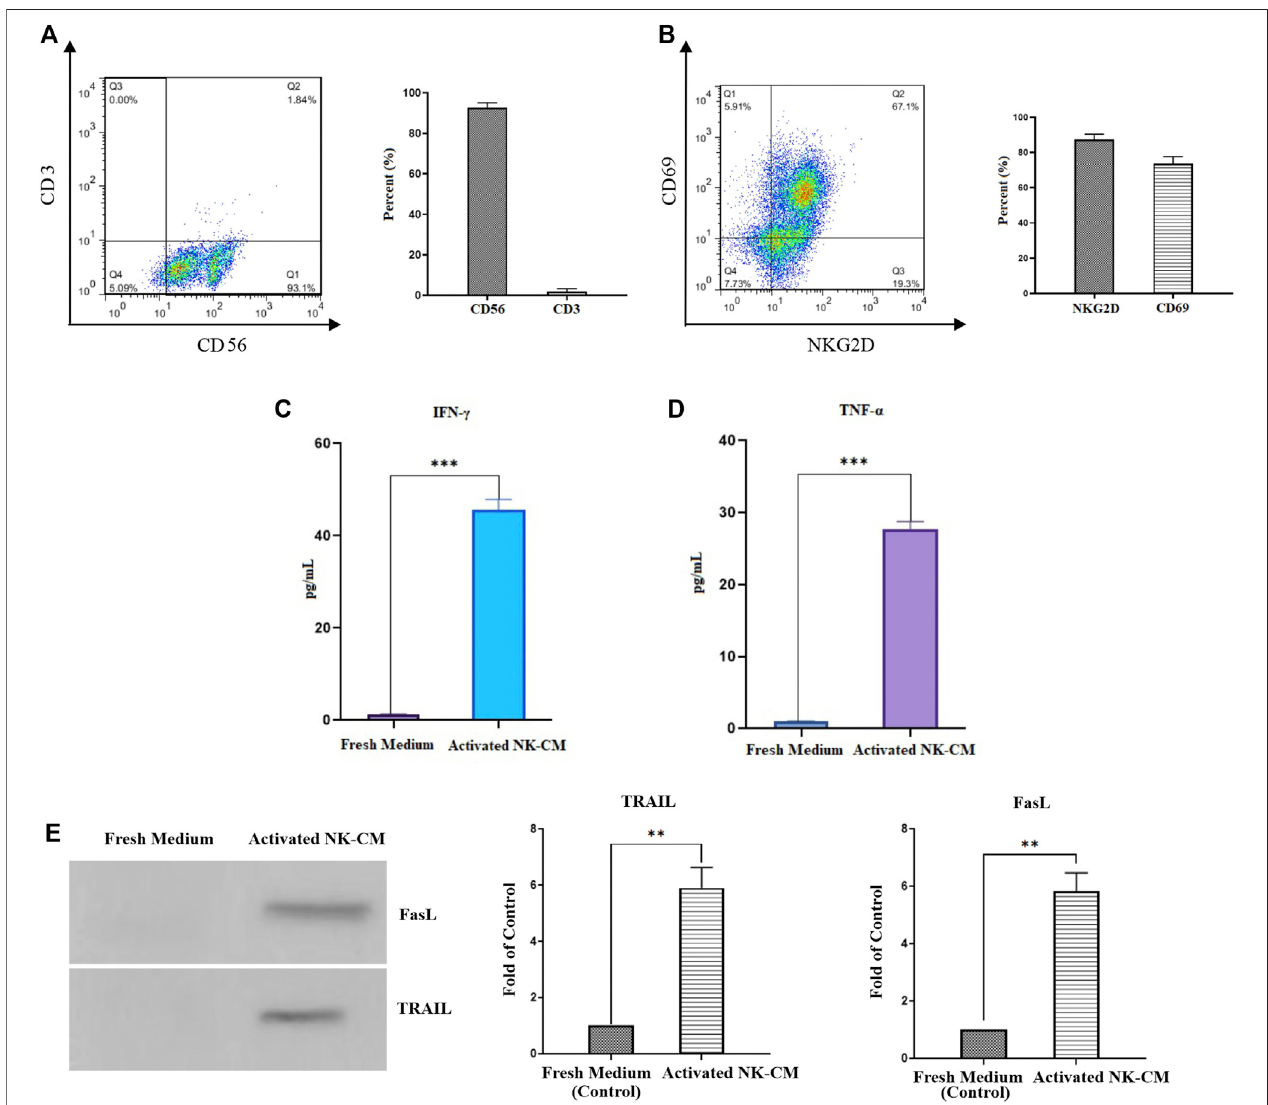
FIGURE 5 | Characterization and activation status of NK cells. (A) The population of CD56 + CD3-NK cells after MACS isolation. (B) The activation status of IL-2- activated NK cells by NKG2D and CD69 markers. (C) The IFN- γ concentration ofIL-2-activated NK cells conditioned medium (NK-CM). (D) The TNF- α concentration of IL-2-activated NK-CM. The immunostimulatory cytokines level of IL-2-activated NK-CM was signi fi cantly increased than the control group (fresh NK cells culture medium). (E) Soluble FasL and TRAIL are present in activated NK-CM determined by western blotting. Data presented as means ± standard error (M± SE). Statistical signi fi cance was determined using an unpaired t -test with * p < 0.05. ns: non-signi fi cant.